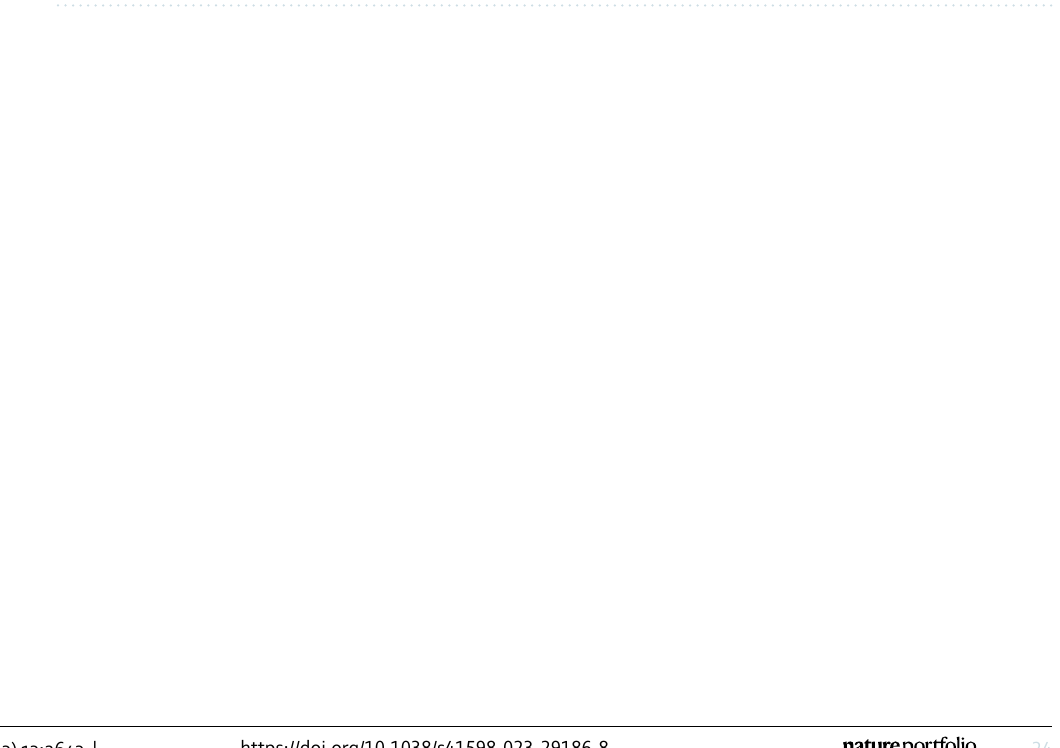
Figure 27. Forced dissipative 2DOF system observations for γ = 2.0